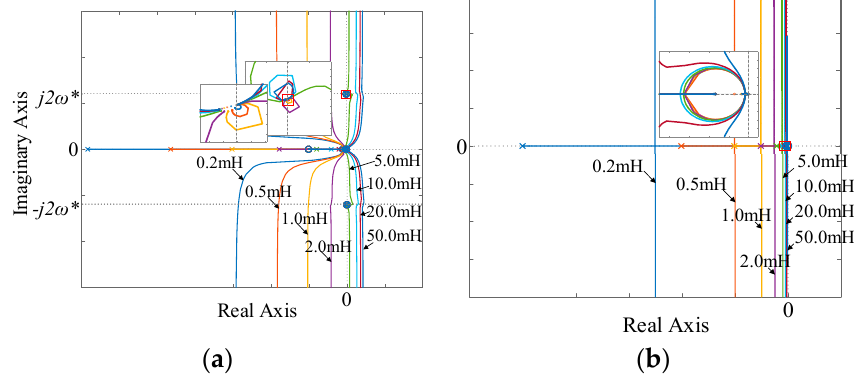
Figure 9. Root locus. ( a ) Traditional current control. ( b ) Dual current loops control.